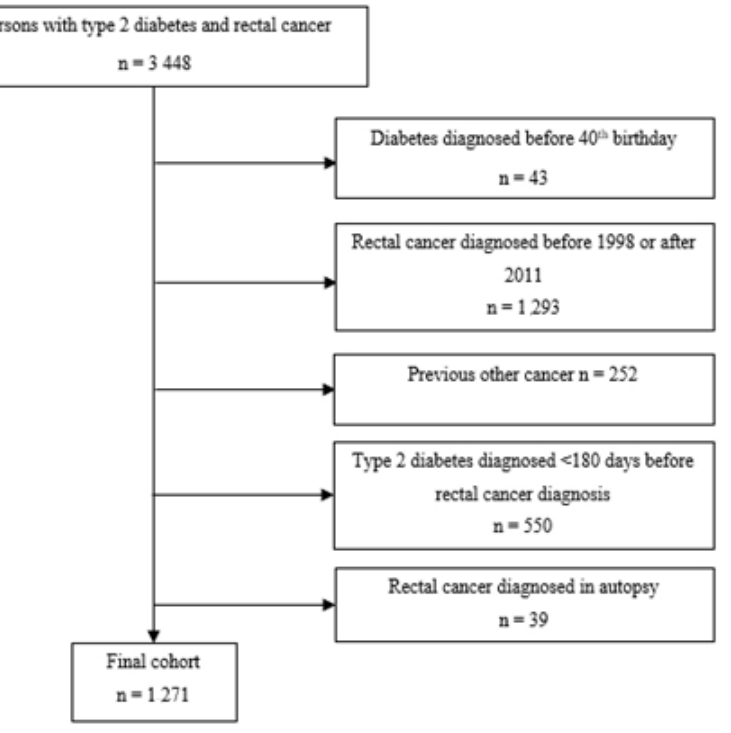
Figure 1. Flowchart of the cohort selection process.